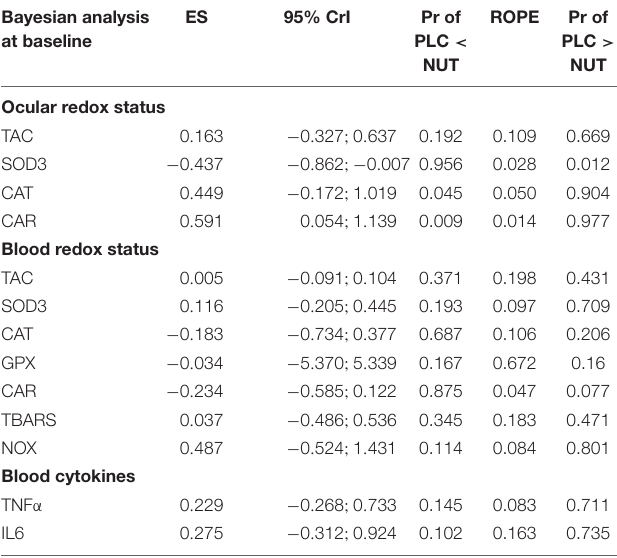
TABLE 8 | Bayesian analysis of redox status and cytokines in RP patients after 2 years of the nutritional supplementation. Bayesian analysis ES 95% CrI Pr of at baseline